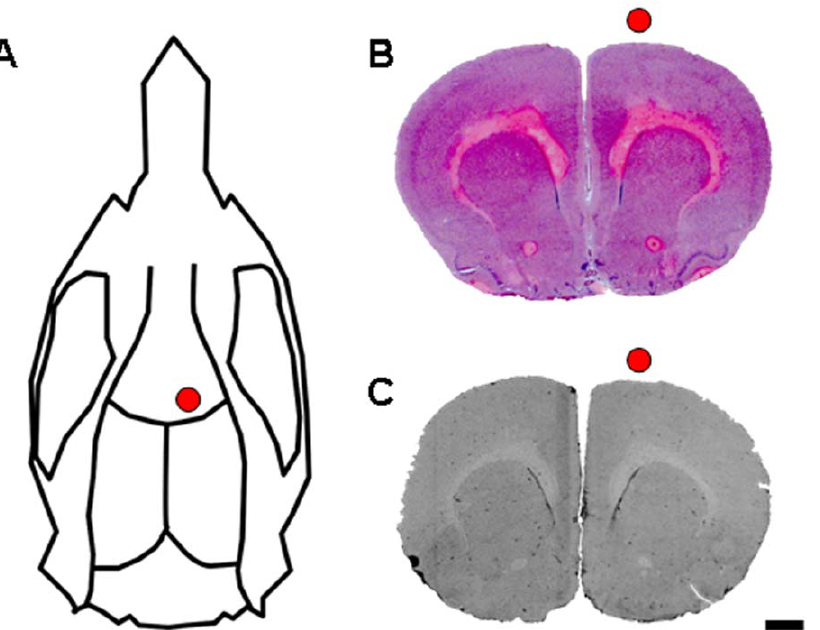
Figure 1. Multi-session transcranial DCS with defined parameters does not cause a cerebral lesion or astrogliotic scar. (A) For multi- session tDCS, an epicranial electrode was mounted as schematically depicted (red circle). (B) H&E staining confirmed an intact cortex after multi- session focal tDCS, and (C) no astrogliotic scarring was detected by GFAP staining (scale bar =1 mm).